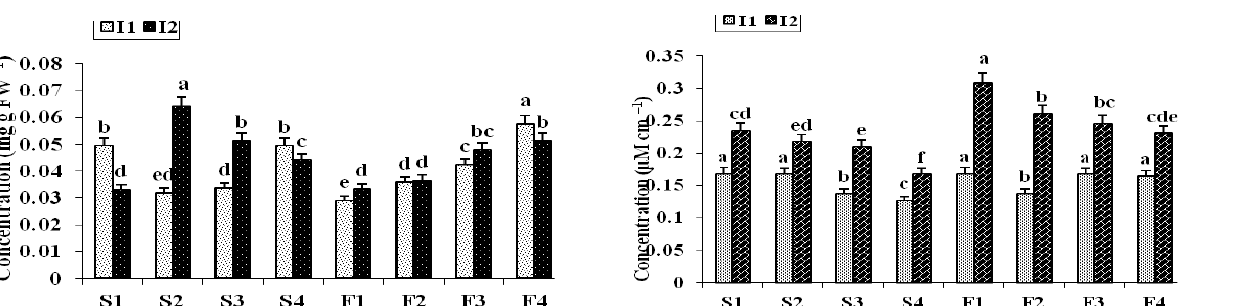
Fig. 8. Changes in malondialdehyde content due to water deficit stress and application of Fe; I1- normal irrigation or irrigation to reach 50% soil moisture depletion of field capacity, I2- irrigation from the beginning of flowering to the end of pollination stage reaching 75% of soil moisture depletion of field capacity; S- soil application of Fe, S1- without soil application of Fe; S2- 50 Fe Kg ha -1 , S3- 100 Fe Kg ha -1 , S4- 150 Fe Kg ha -1 ; F- foliar application of Fe, F1- foliar application of water, F2- 1,000 Fe mg l -1 , F3- 2,000 Fe mg l -1 , F4- 3,000 Fe mg l -1 ; LS MEANS within each column of each section followed by the same letter are not significantly different (p ≤ 0.05)